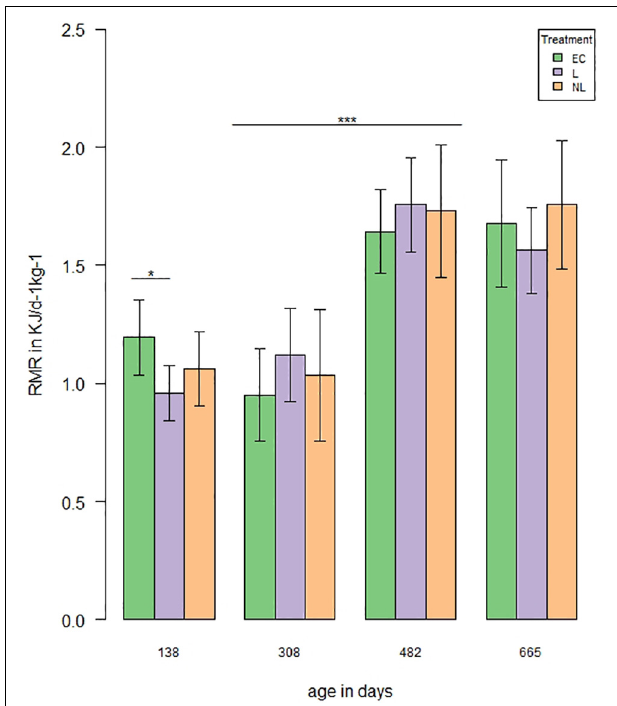
FIGURE 7 | Resting metabolic rate (RMR) over time. RMR was measured four times (138, 308, and 482 days of age n = 48, 665 days of age n = 44). The analysis showed a treatment effect on RMR with an age of 138 days between EC and L mice ( t = 2.58, p = 0.04). RMR increased significantly between the second and third measurement (| t | > 7.0, p < 0.001; * p < 0.05, *** p <